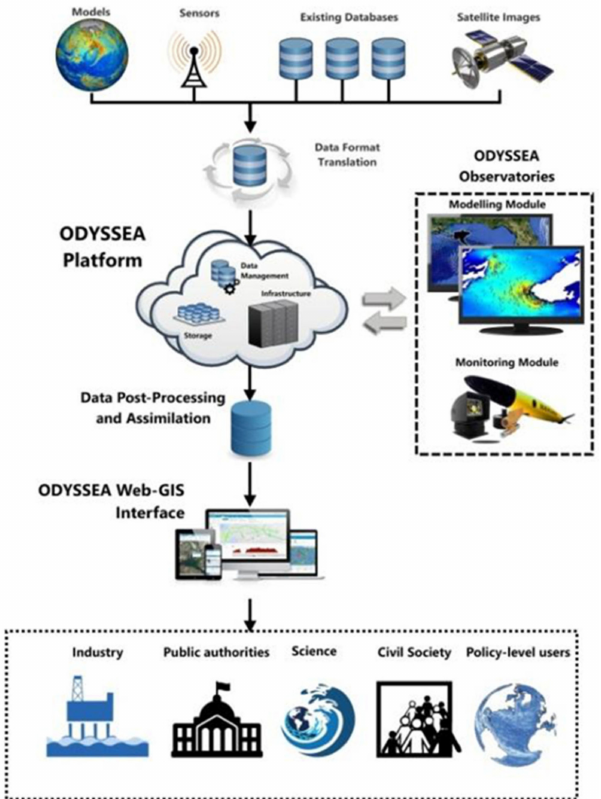
Figure 8. ODYSSEA Platform workflow from sensors and modeling data through the Internet and integration steps leading to post-processing and interface display for a range of decision makers and